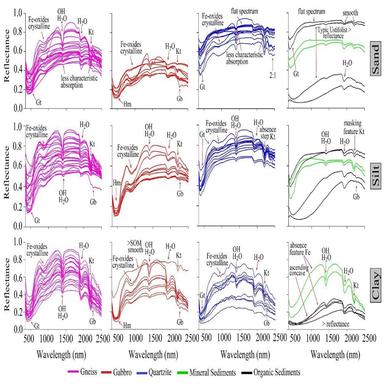
Spectral curves of the sand, silt, and clay fractions of the horizons of Brazilian soils according to their parent materials: gneiss, gabbro, quartzite, mineral sediments, and organic sediments. Kt - Kaolinite, Mc - muscovite, Gb - gibbsite, Gt - goethite, Hm - hematite.